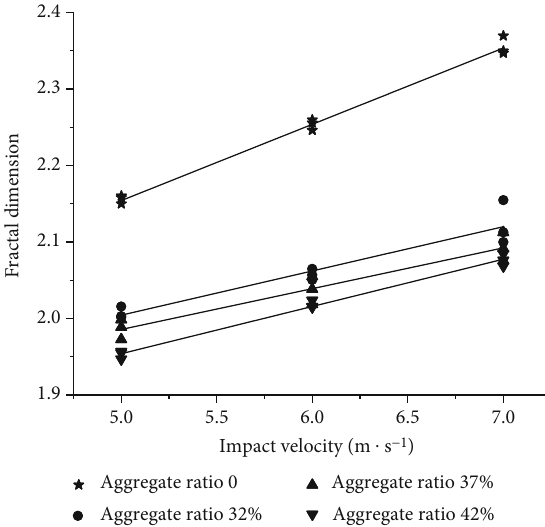
Figure 5: Relationship between impact velocity and fractal dimension.